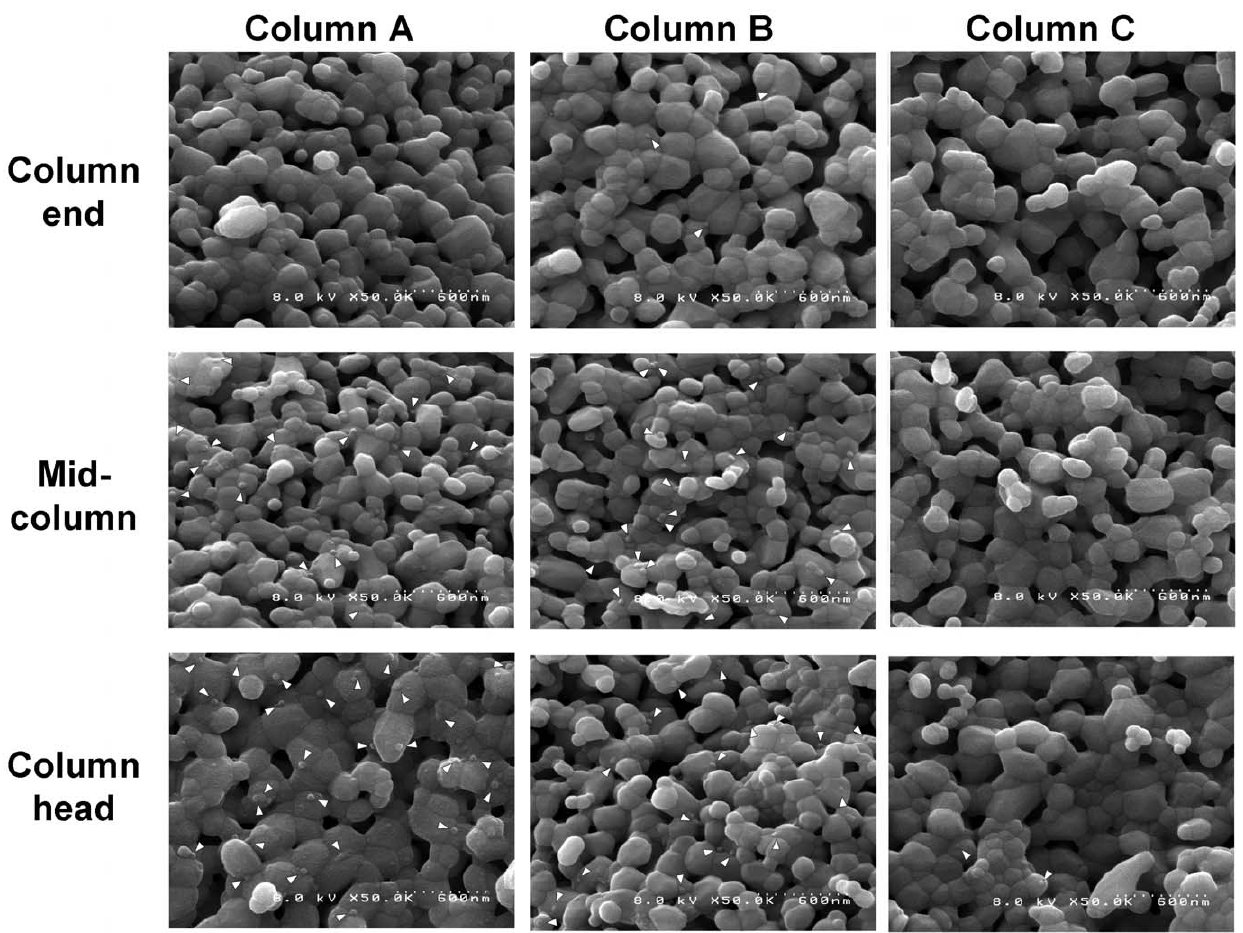
Figure 4. Observation of HAp surfaces that were used in the 3 different elution processes. Column A: No elution; Column B: 10–207 mM NaPB (pH 7.2) gradient elution; Column C: 10–600 mM NaPB (pH 7.2) gradient elution. Each column was divided into 3 sections (Column end, Mid- column, Column head). The white triangles indicate dengue viruses.